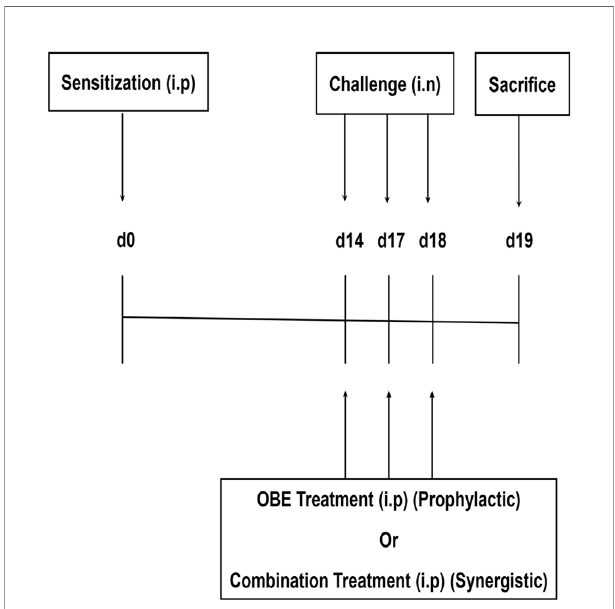
FIGURE 1 | Schemactic representation of the immunization and the treatment protocol used for boh the prophylactic and synergistic